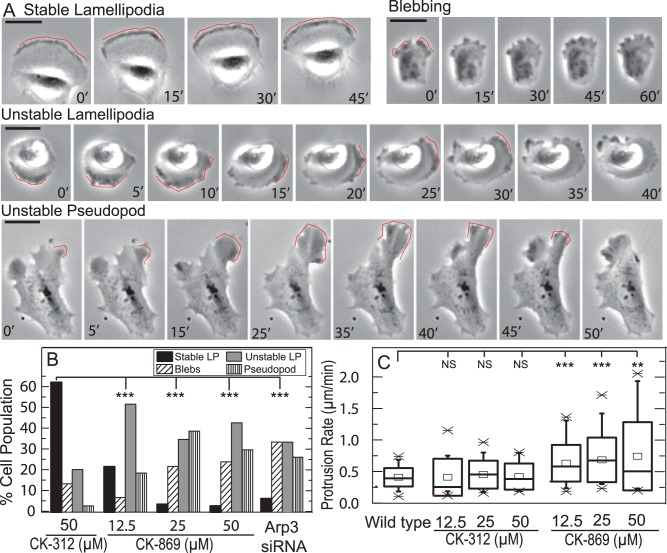
Protrusions observed in MCF10A cells at different concentrations of the Arp2/3 inhibitor, CK-869.(A) Phase contrast images of the protrusion phenotypes observed. A broad lamellipodia that remains stable for ∼1 hr drives persistent migration in wild type cells (Stable LP). Small (1 µm) and dynamic blebs drive local protrusions in cell treated with 50 µM CK-869. Unstable, lamellipodia-like protrusions (Unstable LP) drive local protrusion in cell treated with 50 µM CK-869 over ∼10 min time periods. Protrusions are unstable and appear as a travelling wave along the cell periphery. Large pseudopodial protrusions rapidly extend ∼30 µm over ∼30 min but are unstable and retract shortly thereafter. Red line indicates protrusion of interest for each phenotype. Scale bar is 25 µm. (B) Percentage of cells exhibiting the protrusion phenotype described in A for untreated cells, cells treated with 12.5, 25 and 50 µM of CK-869, 50 µM CK-312 or cells transfected with Arp3 siRNA n = 39, 30, 24, 21 and 27 cells respectively, (C) Box plot of protrusion rate for untreated cells, cells treated with 12.5, 25 and 50 µM of CK 312, and cells treated with 12.5, 25 and 50 µM of CK-869 and imaged for 16 hours. Square  =  mean, X = 1% and 99% quantile. Box is median and SD. n = 39, 13, 14, 17, 30, 24 and 21 cells respectively; NS, not significant; **, P<0.01; ***, P<0.001 with respect to WT or control.